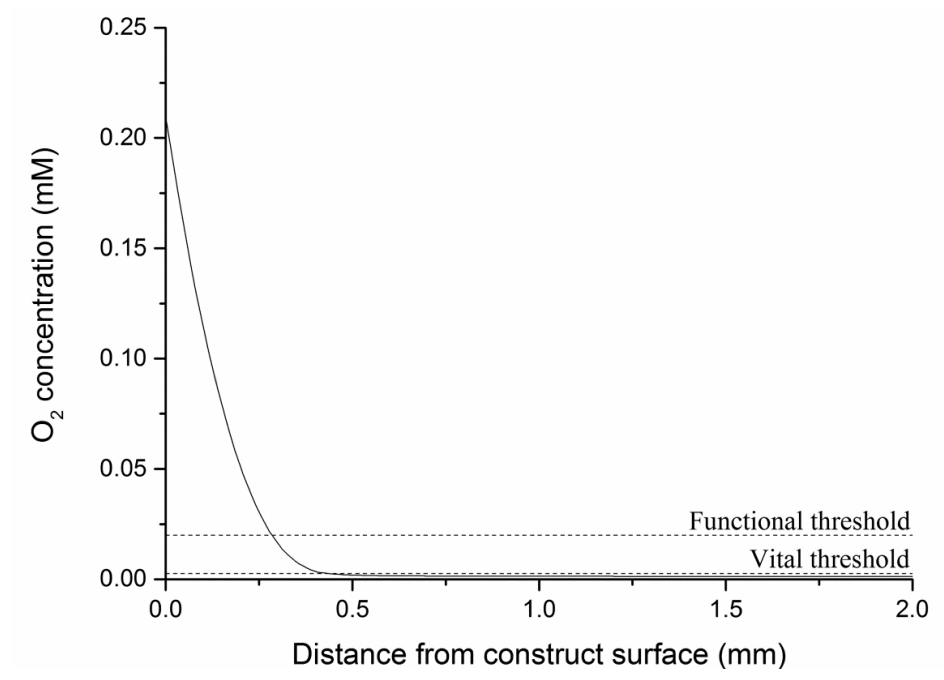
Figure 7. Oxygen concentration profile along a vertical section of a thick construct with a constant oxygen concentration of 0.21 mM at the